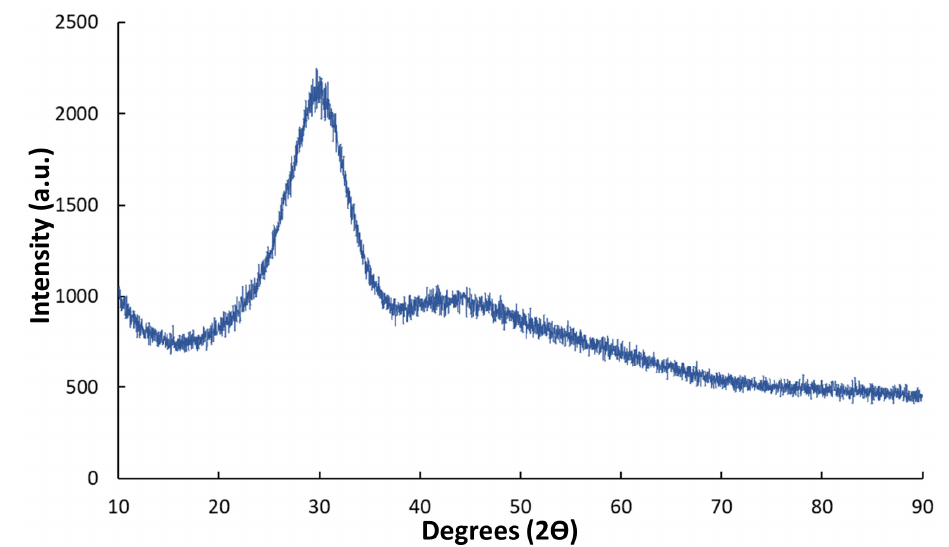
Figure 4. XRD di ff ractogram of BGMSN sintered samples. Figure 4. XRD diffractogram of BGMSN sintered samples. Figure 4. XRD diffractogram of BGMSN sintered samples.